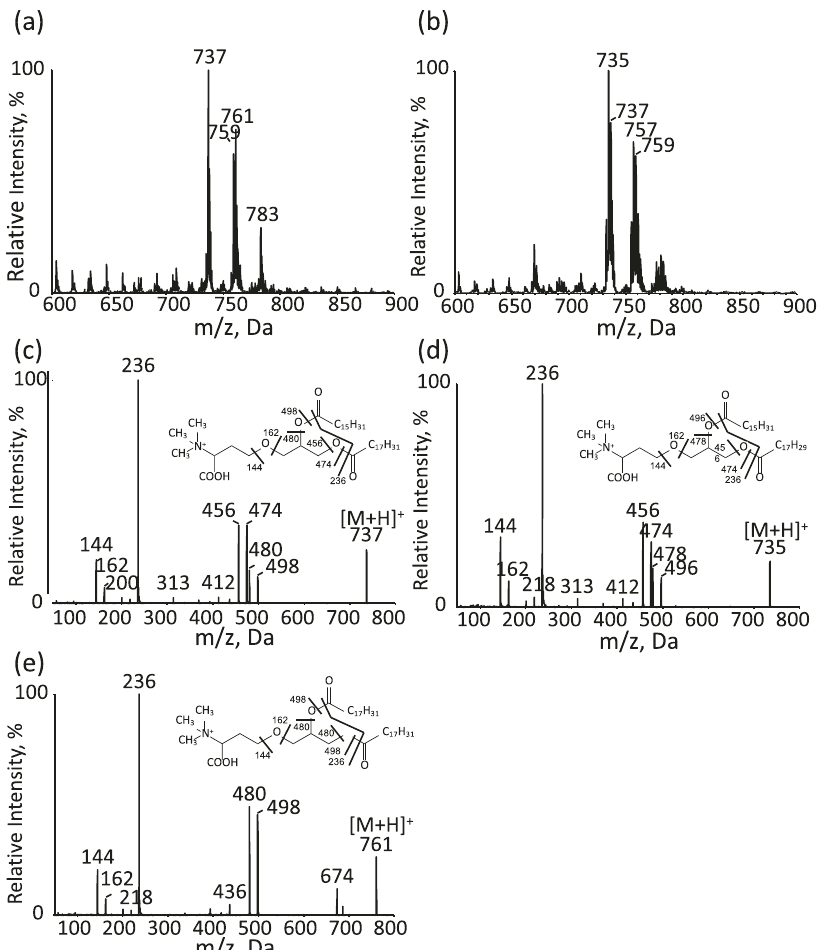
Fig. 4 Identi fi cation of a − P-induced lipid as DGTS through LC/MS 2 analysis. ESI mass spectra as to a − P-induced lipid of C. kessleri ( a ) and DGTS of C. reinharditii ( b ). Product ion spectra ( c ), ( d ), and ( e ), as to m/z 737 in ( a ), m/z 735 in ( b ), and m/z 761 in ( a ),